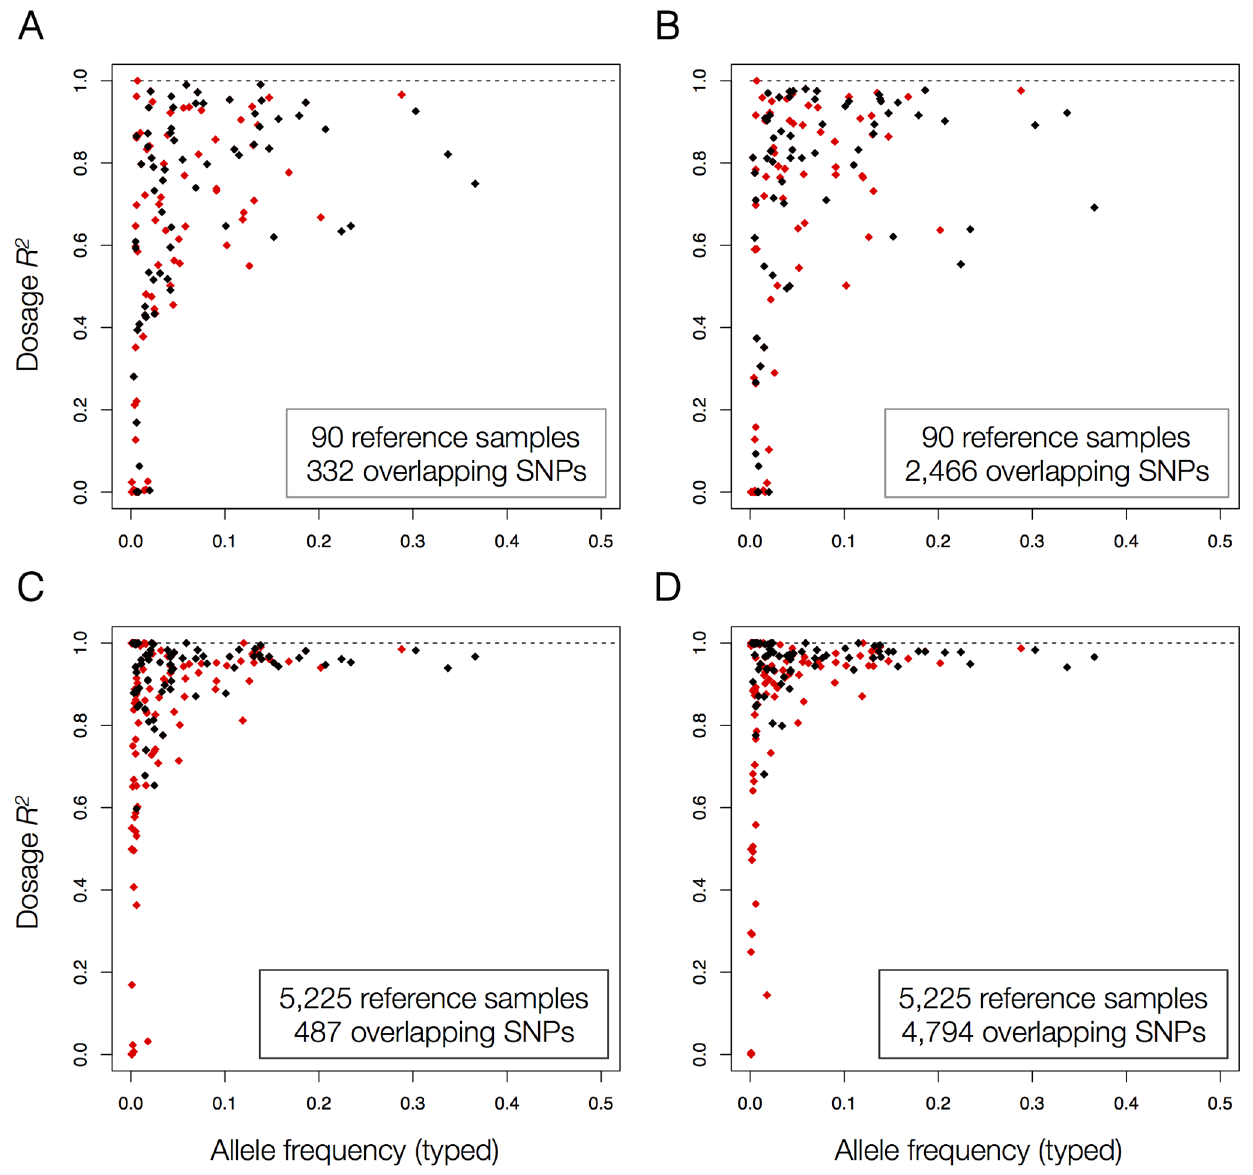
Figure 2. Correlation between imputed and typed dosages ( r 2 dosage ) of classical HLA alleles in the B58BC as a function of typed allele frequency for imputation from the (a) Affymetrix 500 K or (b) Illumina Immunochip platform using the HapMap-CEPH reference panel, and imputation from the (c) Affymetrix 500 K or (d) Illumina Immunochip platform using the T1DGC reference panel. Black points indicate 2-digit HLA alleles. Red points indicate 4-digit HLA alleles.